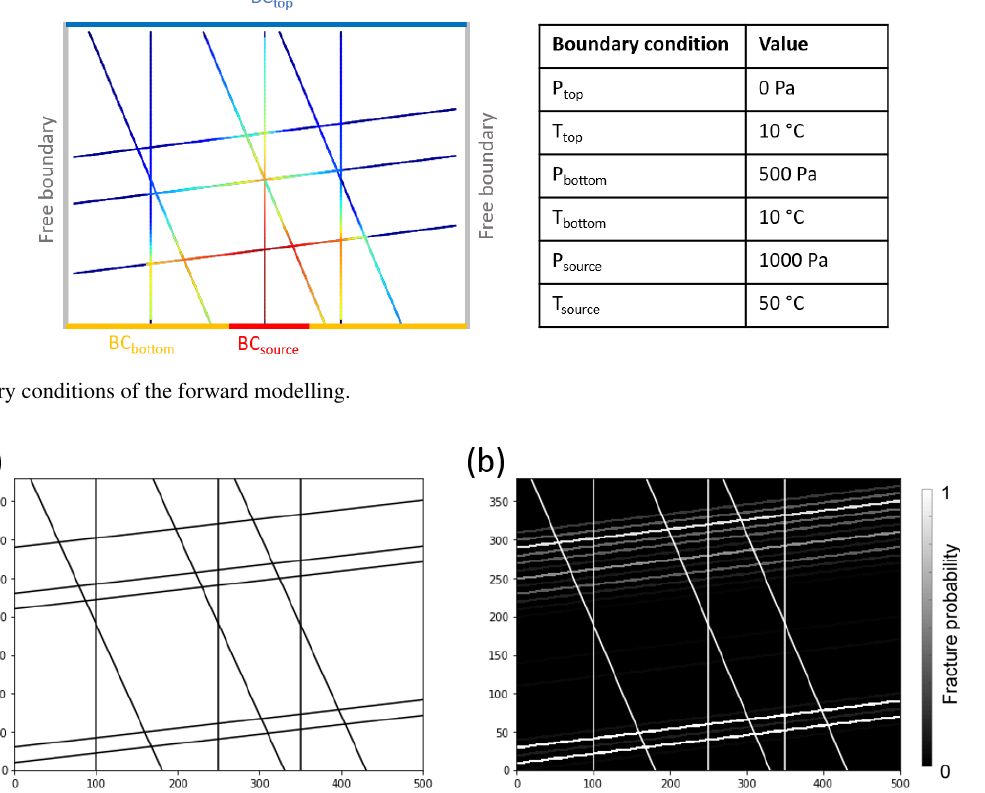
Figure 4. Reconstruction of the synthetic DFN example: (a) Synthetic DFN model, (b) Reconstructed fracture probability